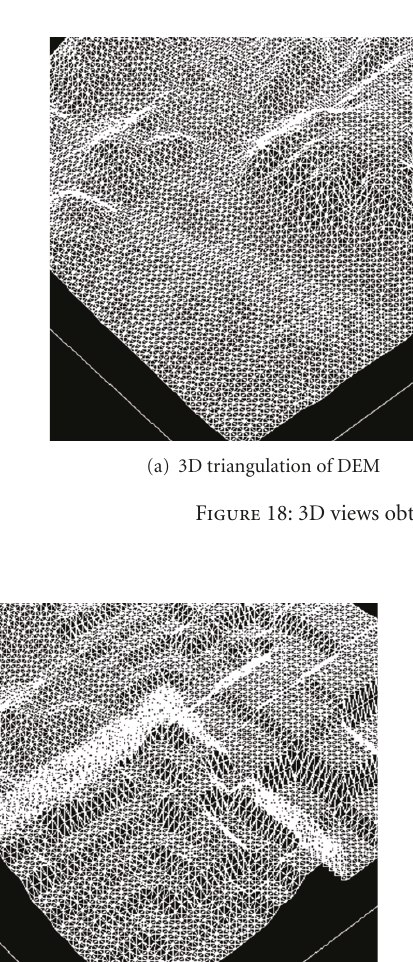
Figure 17: Method II: Example DEM tessellation with l h = 0.